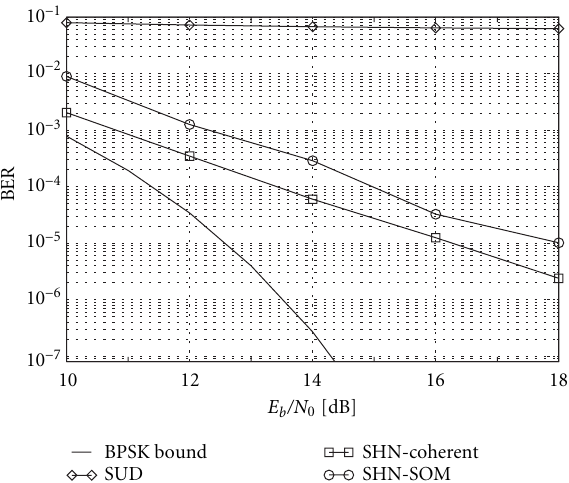
Figure 8: The synchronous case: cumulated BER versus number of iterations.